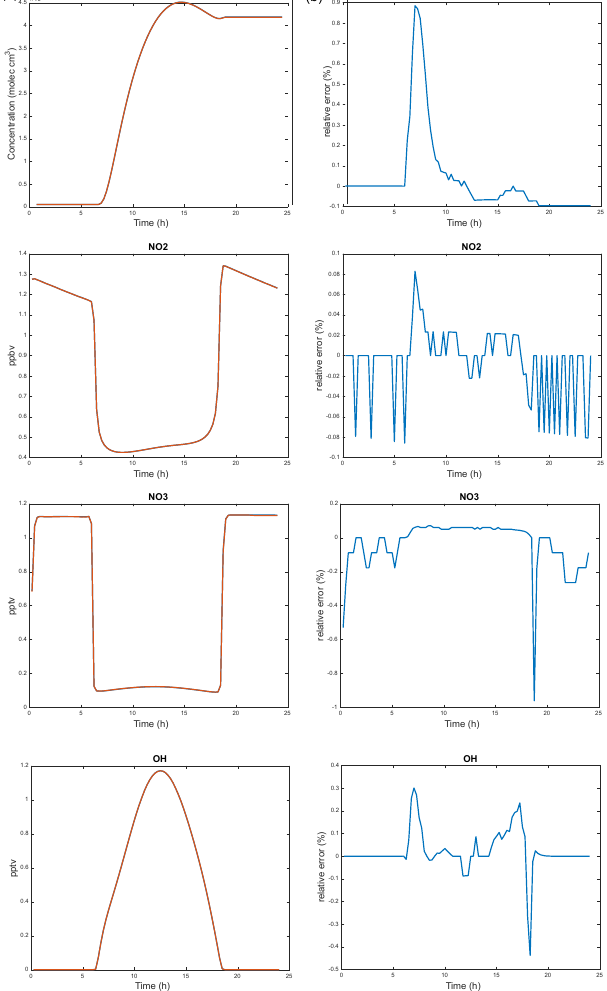
Figure 4. STRATO case. Time evolution of selected species (CH 2 O , NO 2 , NO 3 , OH) for the RS1, and AS2 experiments. (a) shows the mixing ratios or concentrations and (b) the differences in percentage (%) for AS2 relative to the RS1